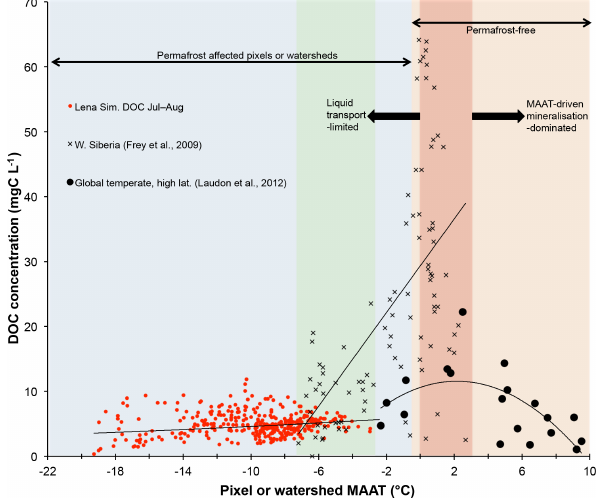
Figure 7. Mean summertime DOC concentrations (mgCL − 1 ) plot- ted against mean annual air temperature (MAAT, ◦ C) for simu- lated pixels over the Lena River basin (red circles); observations for largely peat-influenced areas in western Siberia as reported in Frey et al. (2009) (black crosses); and observations from a global non-peat temperate and high-latitude meta-analysis (black circles) reported in Laudon et al. (2012). The blue region repre- sents permafrost-affected areas, while the orange region represents permafrost-free areas. The green region bounds the area of overlap in MAAT between the observed and simulated datasets. The dark red shaded area corresponds to the MAAT “zone of optimality” for DOC production and transport proposed by Laudon et al. (2012). Regression curves of DOC against MAAT for each of the separate datasets are shown for each individual dataset.